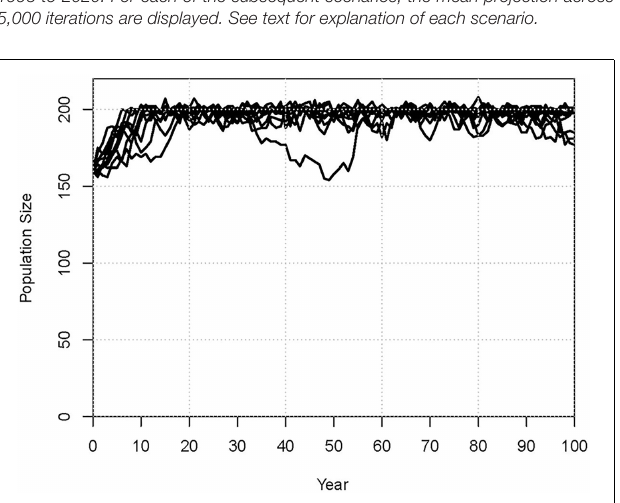
FIGURE 3 | Population trajectories for a sample of 10 iterations of the Baseline scenario, illustrating the typical variation among iterations and across years of the simulation.